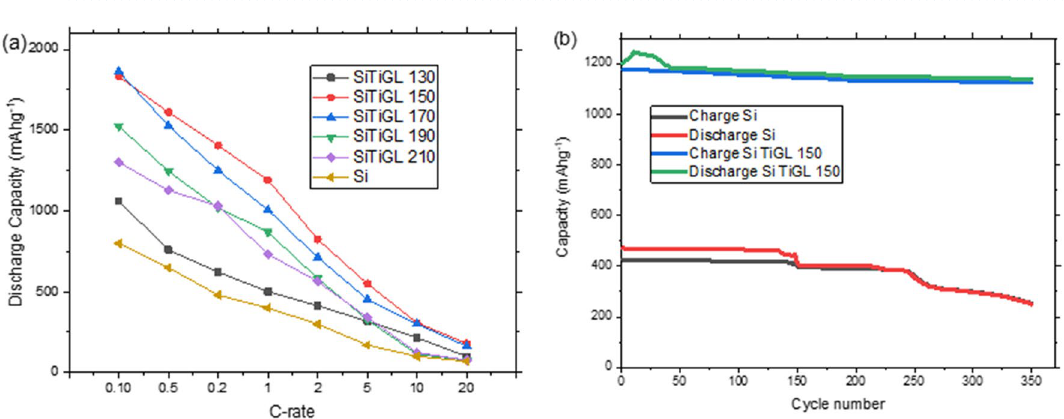
Figure 4. Electrochemical tests ( a ) C-rate test for all samples and ( b ) capacity retention measured at 1 C for Si baseline and Si TiGL